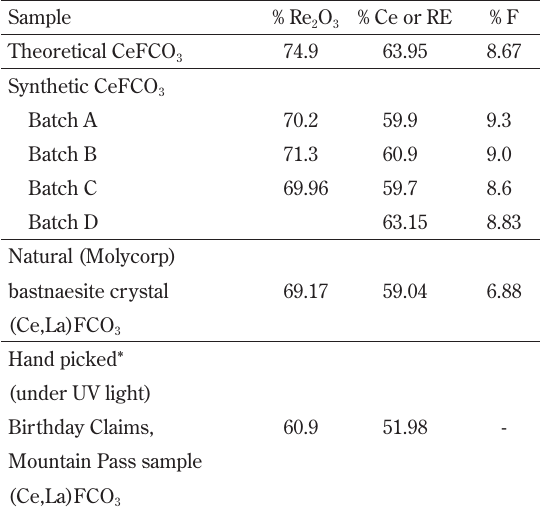
Table 1 Analysis of synthetic cerium bastnaesite and natural mineral samples